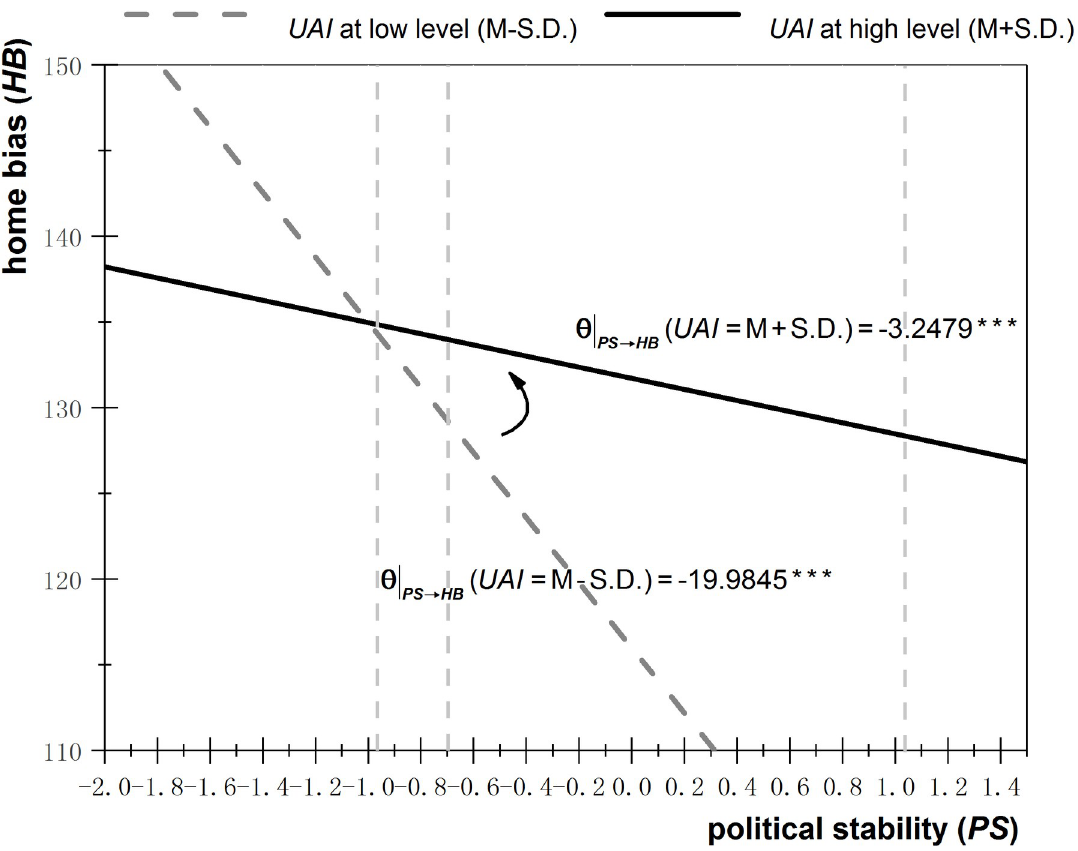
Fig 1. Effects of political stability on home bias under different degrees of uncertainty